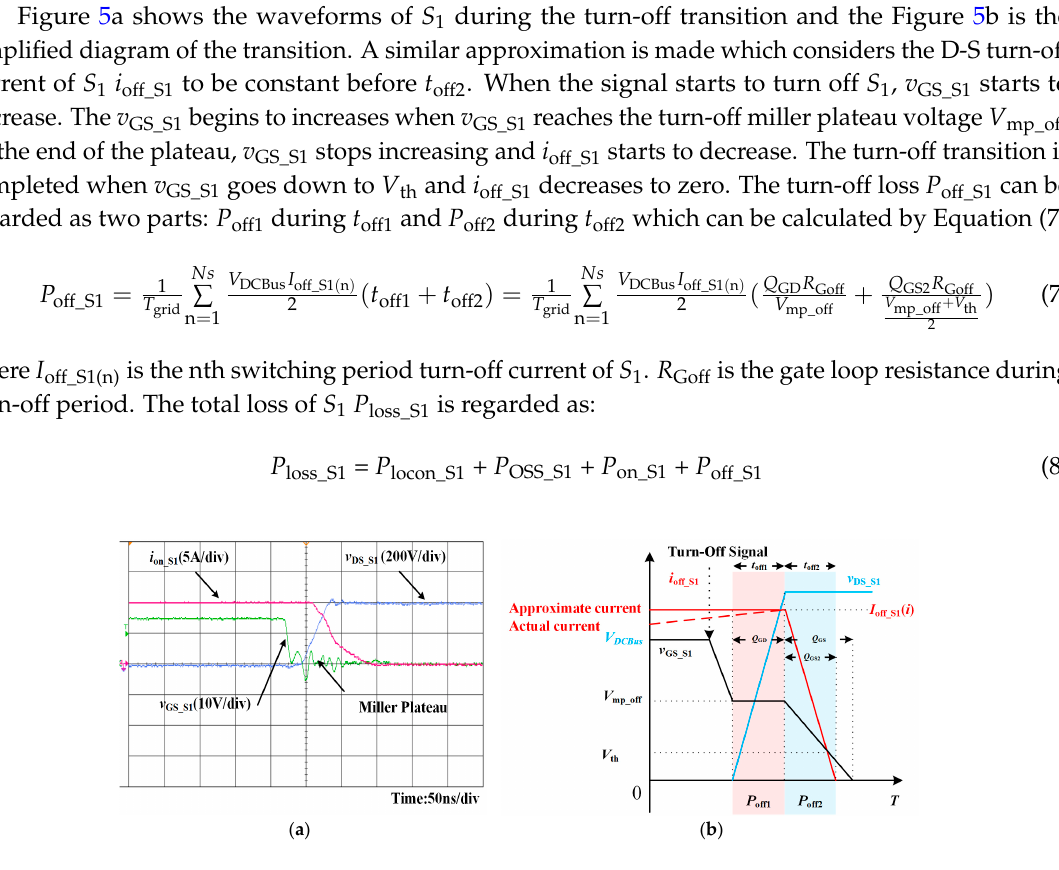
Figure 5. The voltage and current waveforms during turn-off transition: ( a ) the measured waveform during the turn-off transition; and ( b ) the simplified diagram of the turn-off transition.